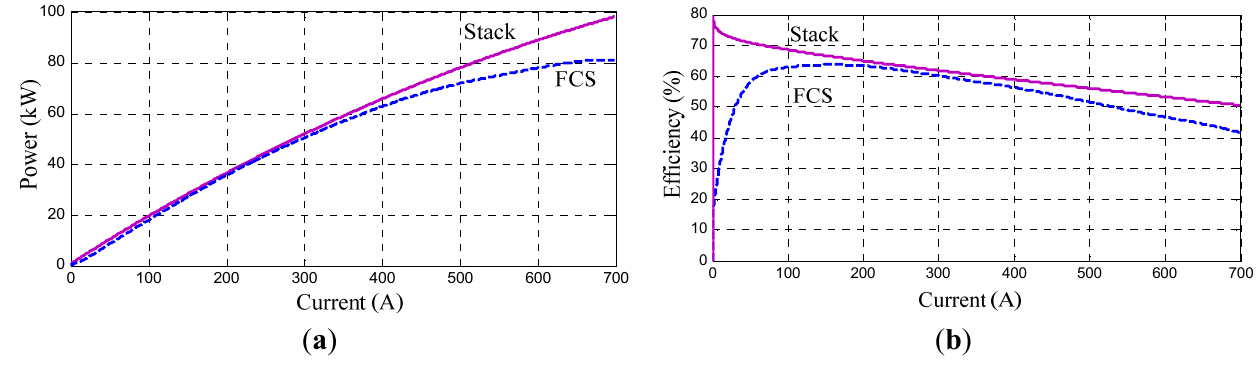
Figure 4. ( a ) Relationship between stack current and power; and ( b ) relationship between stack current and efficiency. FCS: FC system.